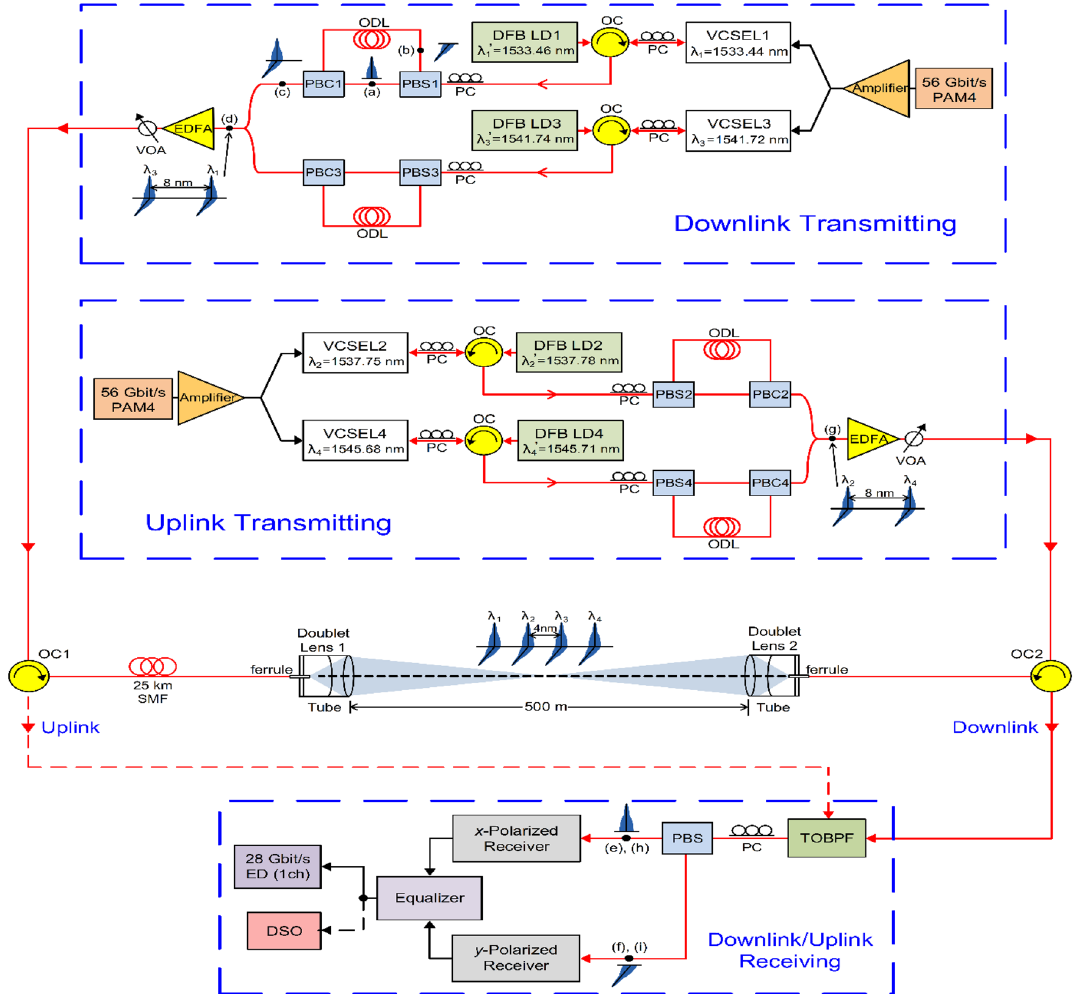
Figure 5. Framework of the demonstrated two-way 224-Gbit/s PAM4-based fibre-FSO converged system adopting injection-locked VCSELs with polarisation-multiplexing